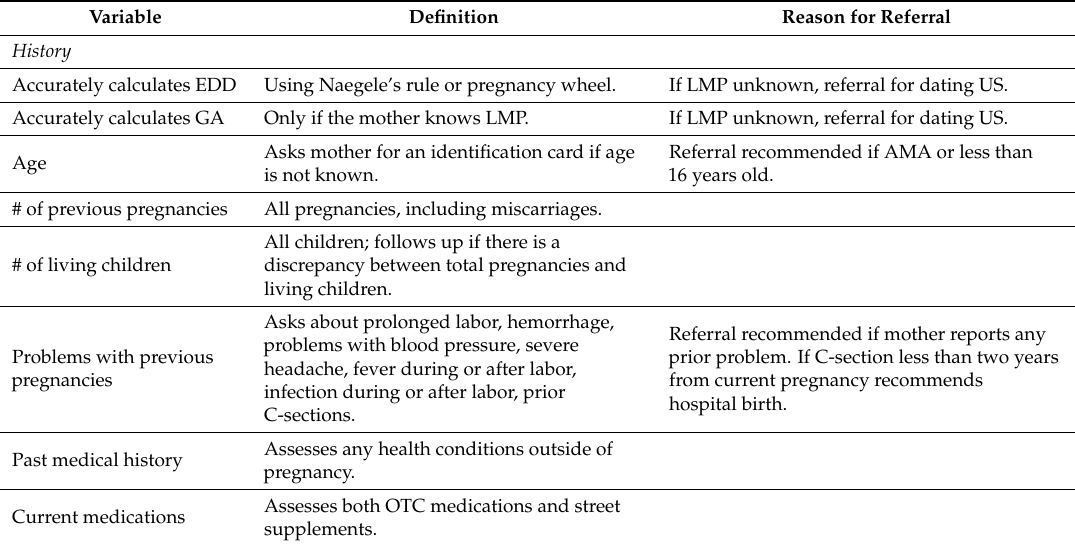
Table 3. The variables included in the prenatal clinical skills observation